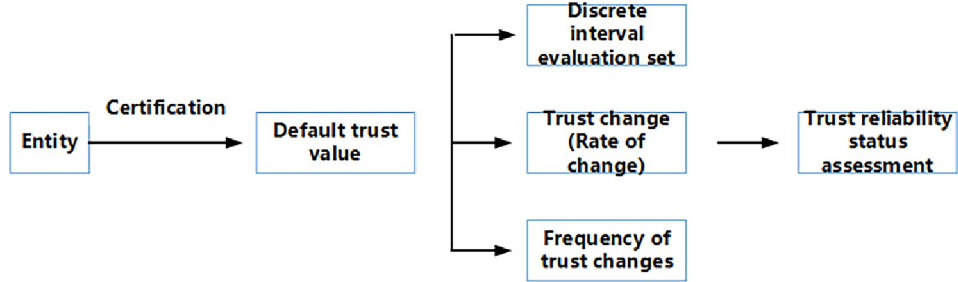
Fig 1. Flow chart for evaluating the trend of trust